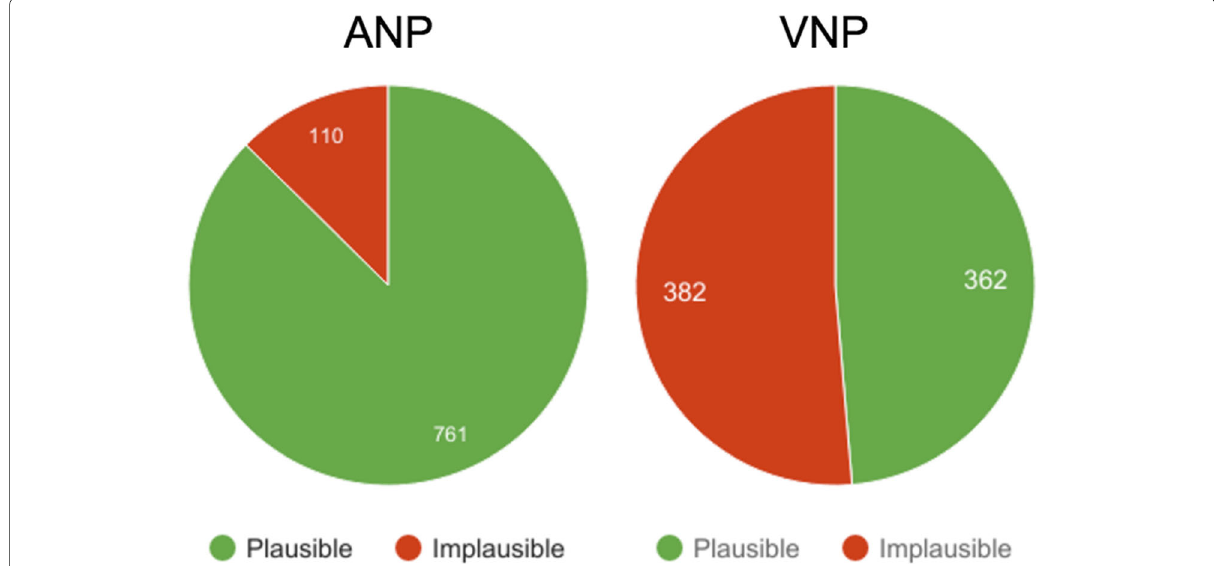
Fig. 3 Plausible and implausible pairs. The charts show the number of plausible and implausible pairs after using both methods, manual inspection and plausibility score. In contrast to adjectives, verbs have more restrictions in how they can be combined with nouns to convey plausible